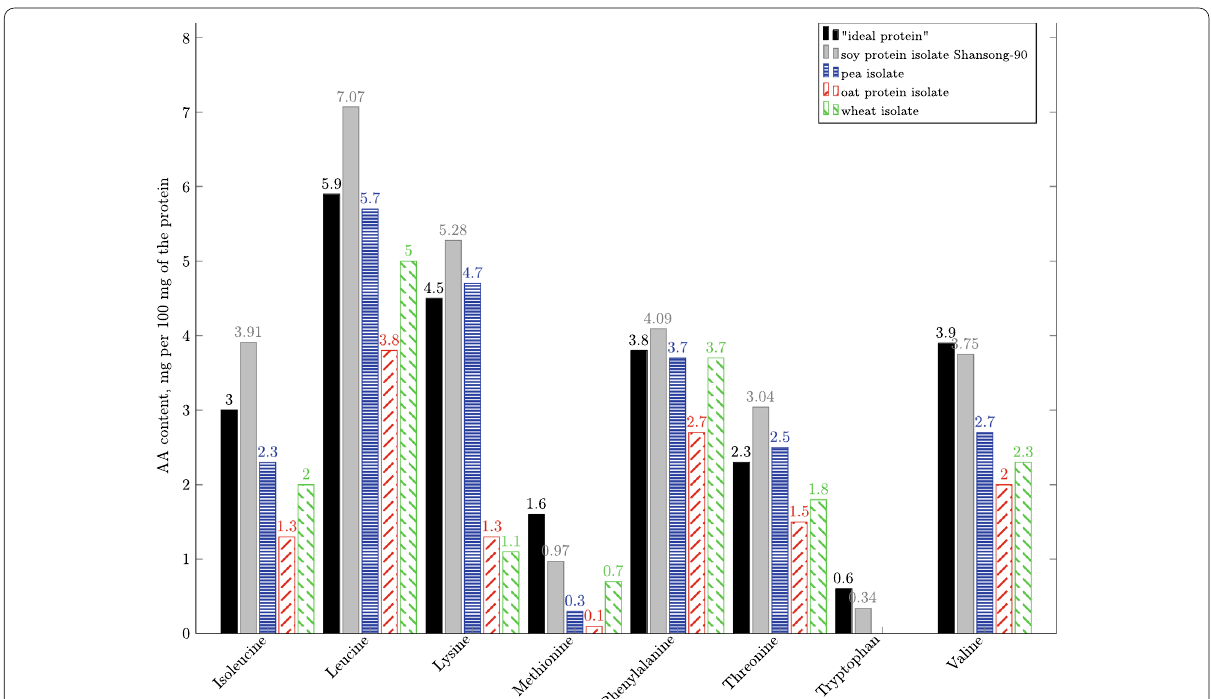
Fig. 1 Amino acid profiles of commercially available plant-based proteins The graph was made using the following sources: “ideal protein” [7], soy protein isolate Shansong-90 (Muranova et al. 2018), pea isolate (Gorissen et al. 2018), oat protein isolate (Gorissen et al. 2018) and wheat isolate (Gorissen et al.